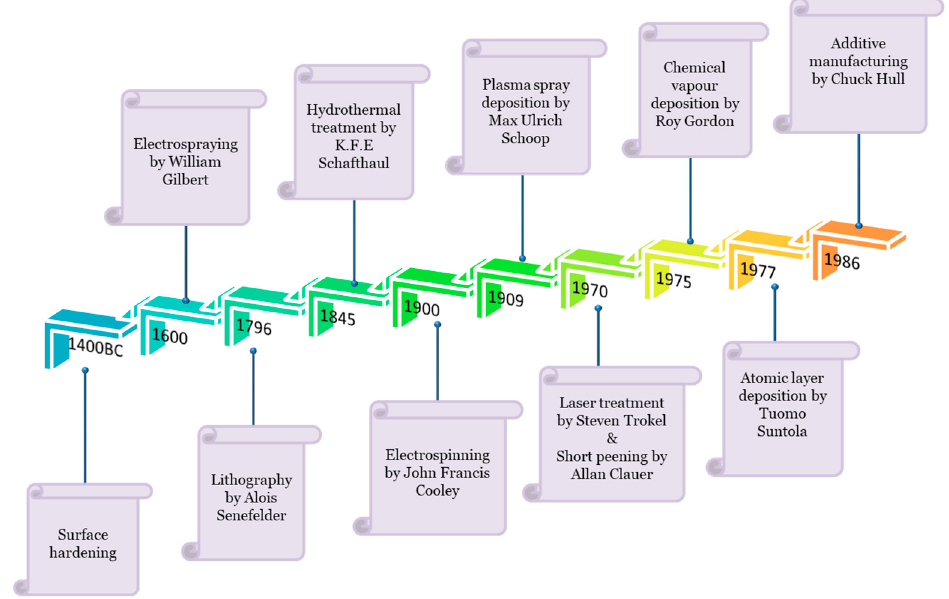
Figure 1. Surface engineering methods have evolved from basic coating techniques to atomic scale deposition methods. This schematic illustration shows the timeline chart of a few surface engineering techniques that are finding biomedical applications.